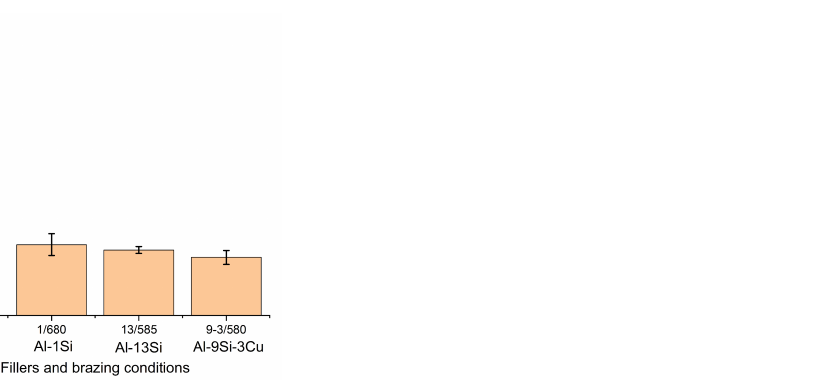
Figure 21. Average intermetallic thicknesses with their standard error at the interfaces of the brazed joints (close to the middle of the joints).